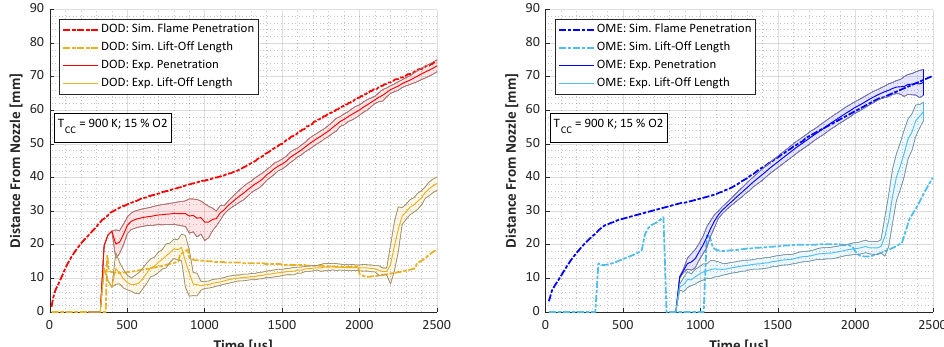
Figure 14. Conti3L: Multi-injection spray lift-off length and penetration for reactive conditions. ArM : T CC = 900 K, 15% O 2 and t inj = 300/500/1200 µ s. ( left ) Dodecane. ( right )